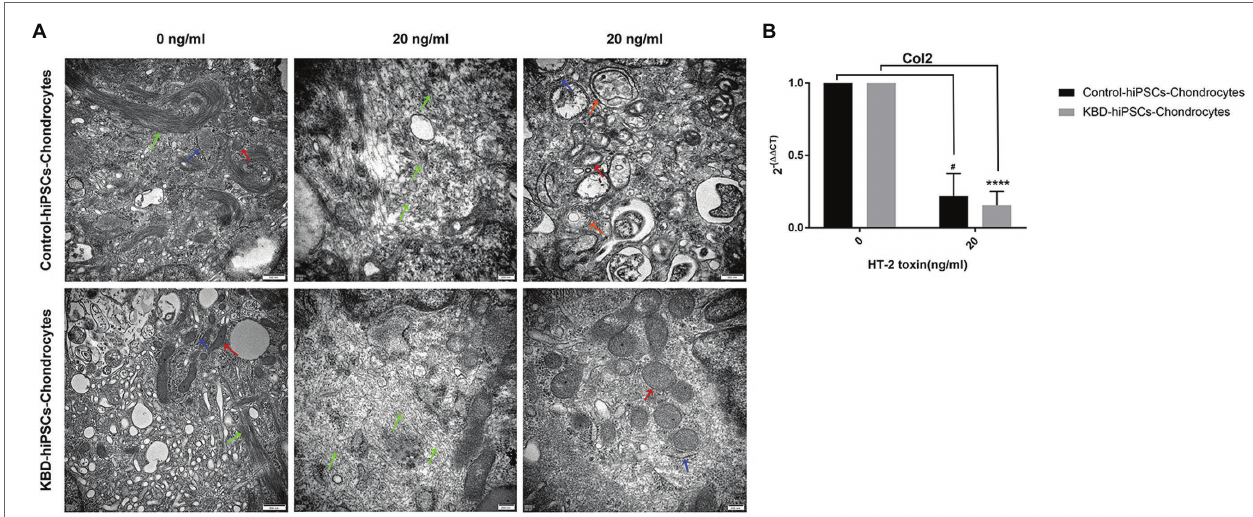
FIGURE 4 | HT-2 toxin inhibited the hiPSCs differentiating to chondrocytes and downregulated Col2 expression. (A) TEM showed that ultrastructure changes in the hiPSC chondrocytes after HT-2 toxin exposure; red arrowheads indicate mitochondria, green arrowheads indicate microtubules, blue arrowheads indicate endoplasmic reticulum, and orange arrowheads indicate autophagic vacuole. (B) Col2 mRNA expression was downregulated after treatment with HT-2 toxin in the hiPSC chondrocytes. # A difference between HT-2 toxin treatment (20 ng/ml) and non-toxin treatment of the control hiPSC chondrocytes, p < 0.05. ****A significant difference between the HT-2 toxin-treated and non-treated KBD–hiPSC chondrocytes, p < 0.0001. hiPSCs, human induced pluripotent stem cells; TEM, transmission electron microscopy; KBD, Kashin–Beck disease.